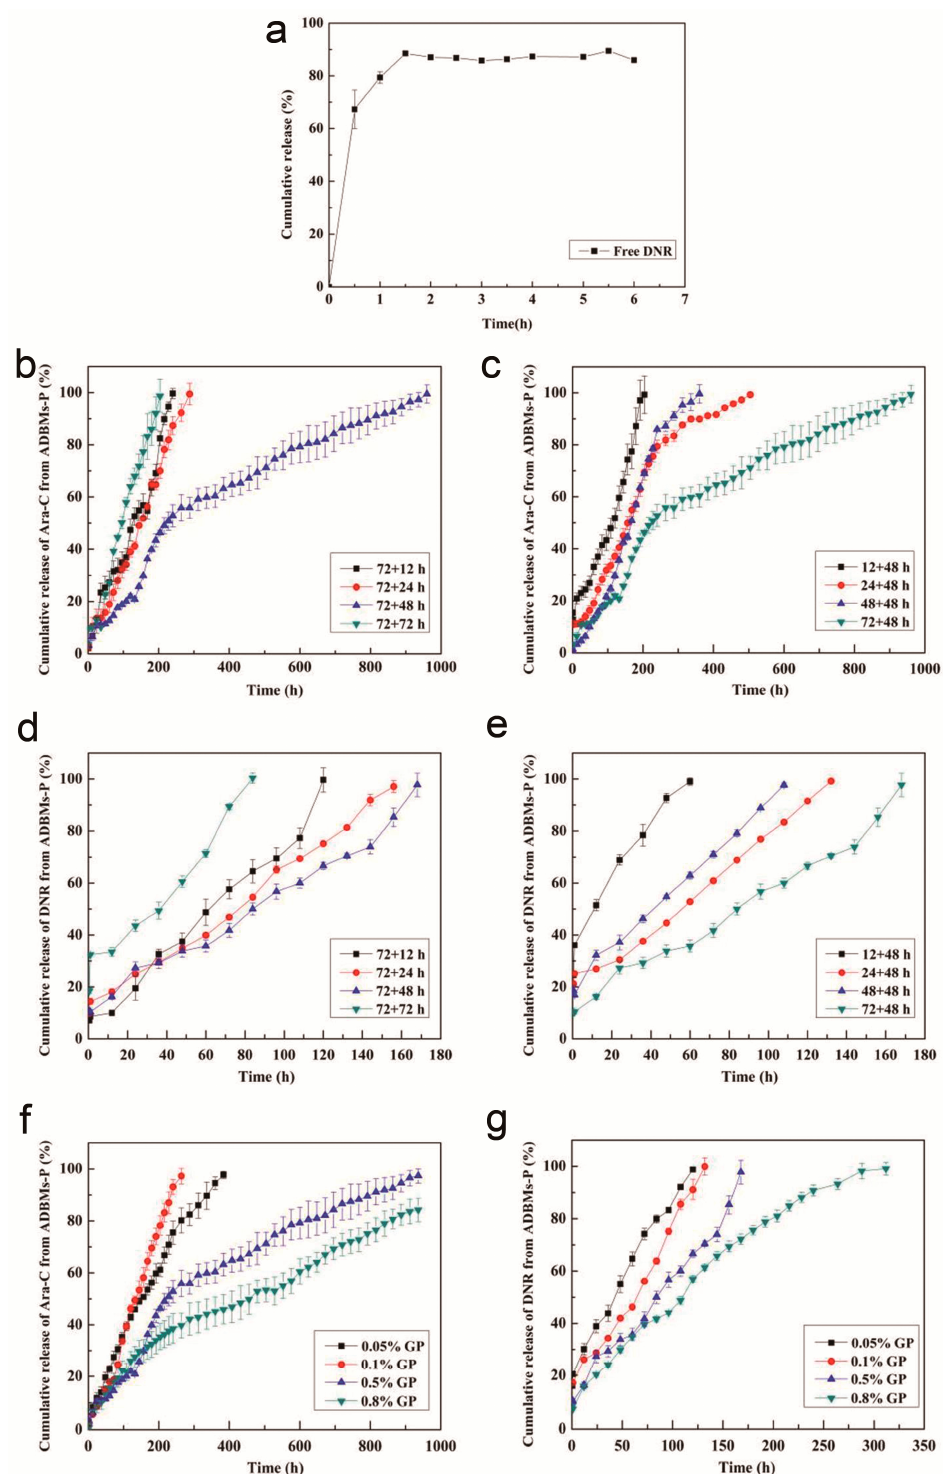
Figure 3. Cumulative release of: ( a ) DNR; and ADBMs-P preparation with different reaction time: ( b , c ) Ara-C; and ( d , e ) DNR; and different GP concentration: ( f ) Ara-C; and ( g ) DNR.